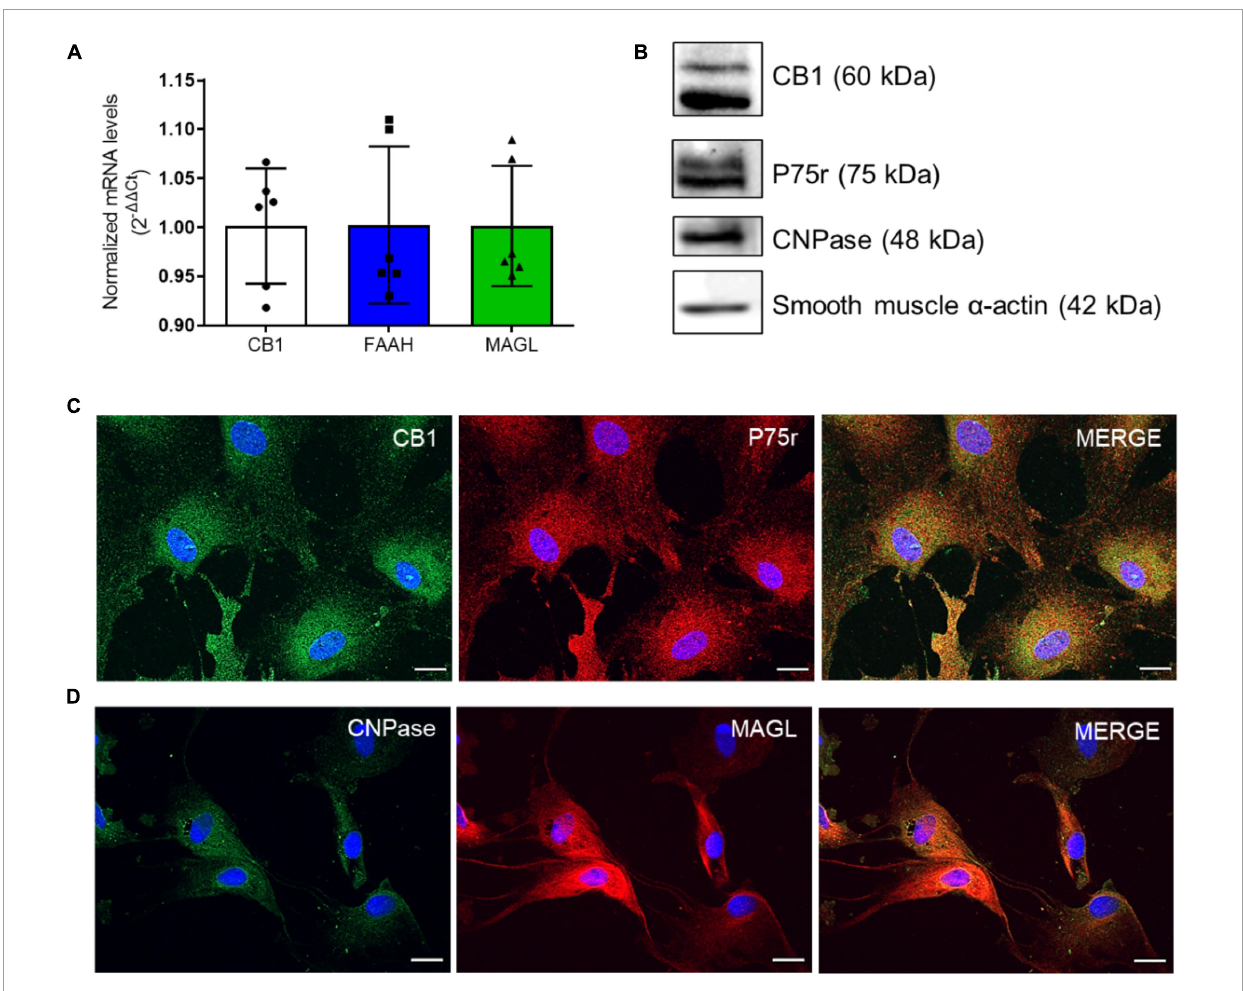
FIGURE1 OEG cell cultures express markers of the endocannabinoid system (ECS). In panel (A) , CB1, FAAH and MAGL mRNA levels in OEG cells in culture. N = 6. In panel (B) , western blotting analysis shows the expression of CB1 and the main markers of OEG cell culture (P75r, CNPase and smooth muscle α -actin). Representative image from different experiments. N = 3. In panel (C) , immunocytochemistry in OEG cell culture for CB1 (in green) and P75r (in red) and in panel (D) , CNPase (in green) and MAGL (in red). Cell nuclei are shown in blue (DAPI). Magnification of 40x, scale bar: 20 µ m. N =